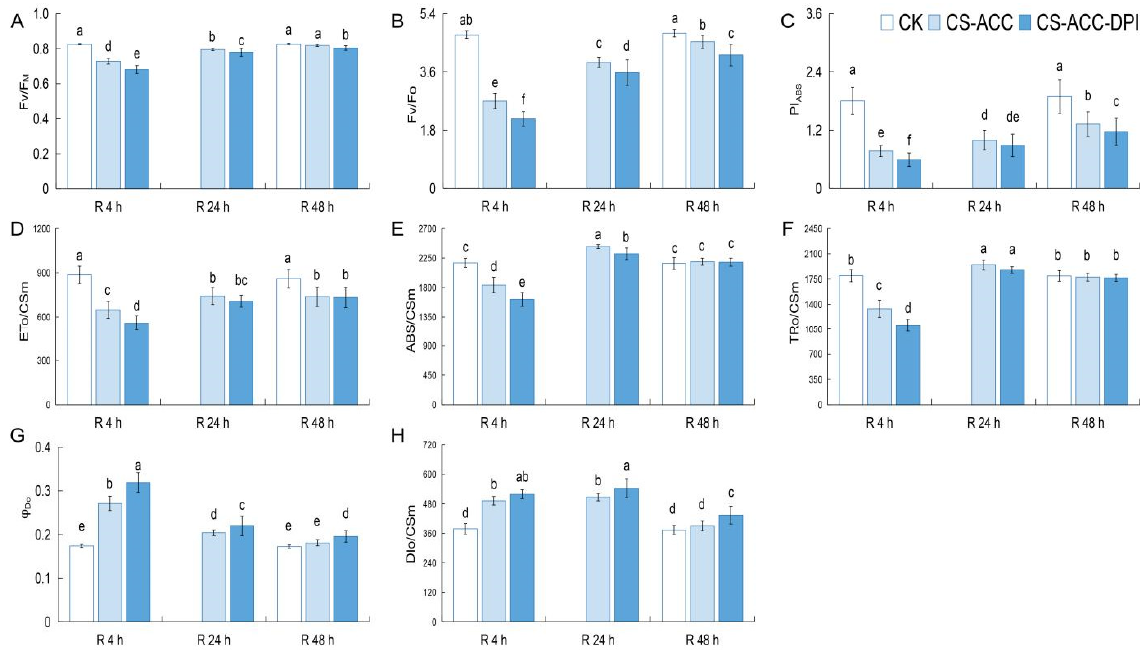
Figure 6. RBOH -dependent signaling affected the different photosynthetic efficiency-related parameters F V /F M ( A ), F V /F O ( B ), PI ABS ( C ), ETo/CSm ( D ), ABS/CSm ( E ), TRo/CSm ( F ), φ Do ( G ), DIo/CSm ( H ) of PSII during recovery after CS-ACC in cucumber seedlings. CK: control, cucumber seedlings with no acclimation and at 25 °C during recovery; CS-ACC: cucumber seedlings were treated with a cold stress regime of 10 °C for 1 h, 25 °C for 1.5 h, and 1 °C for 3 h; CS-ACC-DPI: DPI was sprayed onto the seedlings during recovery after CS-ACC. CS-ACC: cold stress acclimation; R: recovery, 25 °C. F V /F M : maximum light energy conversion efficiency of the PSII reaction center; F V /F O : the potential photochemical activity of PSII; PI ABS : performance index based on the absorbed light energy; ETo/CSm: the energy captured by per unit leaf section for electron transport; ABS/CSm: the light energy absorbed per unit leaf section; TRo/CSm: the energy flux captured by the active reaction center of PSII per unit leaf section; φ Do : quantum ratio used for heat dissipation at t = 0; DIo/CSm: the energy of heat dissipation per unit leaf cross-section. The specific activity parameters accurately reflect the absorption, transformation, and dissipation of light energy by the photosynthetic organs when the fluorescence reaches its maximum. The different letters indicate significant differences as assessed by the Turkey HSD test ( p < 0.05; n ≥ 4).